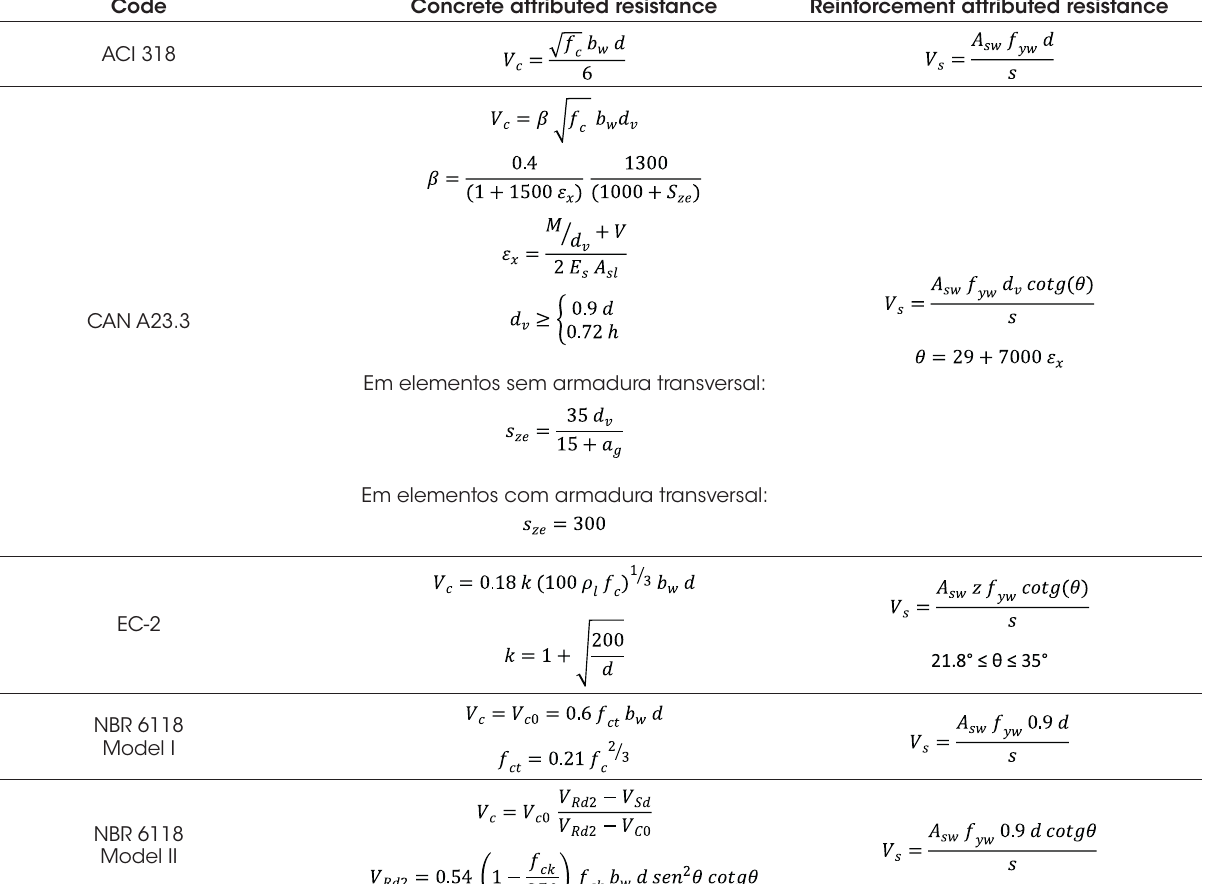
Code based equations to prediction of shear resistance of beams